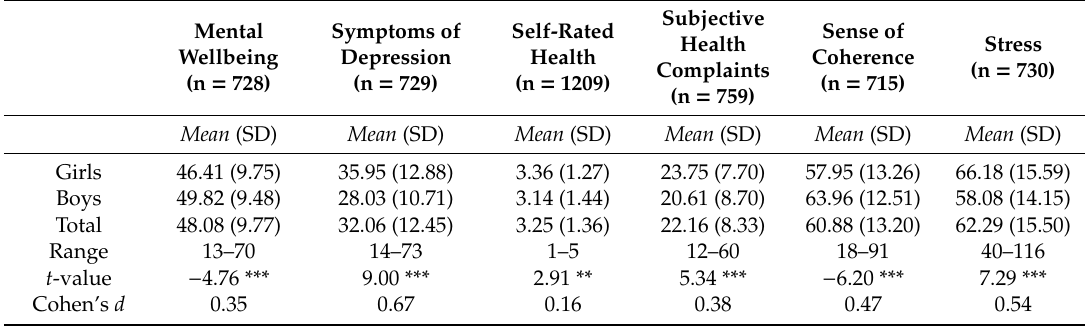
Table 2. Sex mean di ff erences on stress, sense of coherence, mental wellbeing, symptoms of depression, self-rated health, and subjective health complaints.